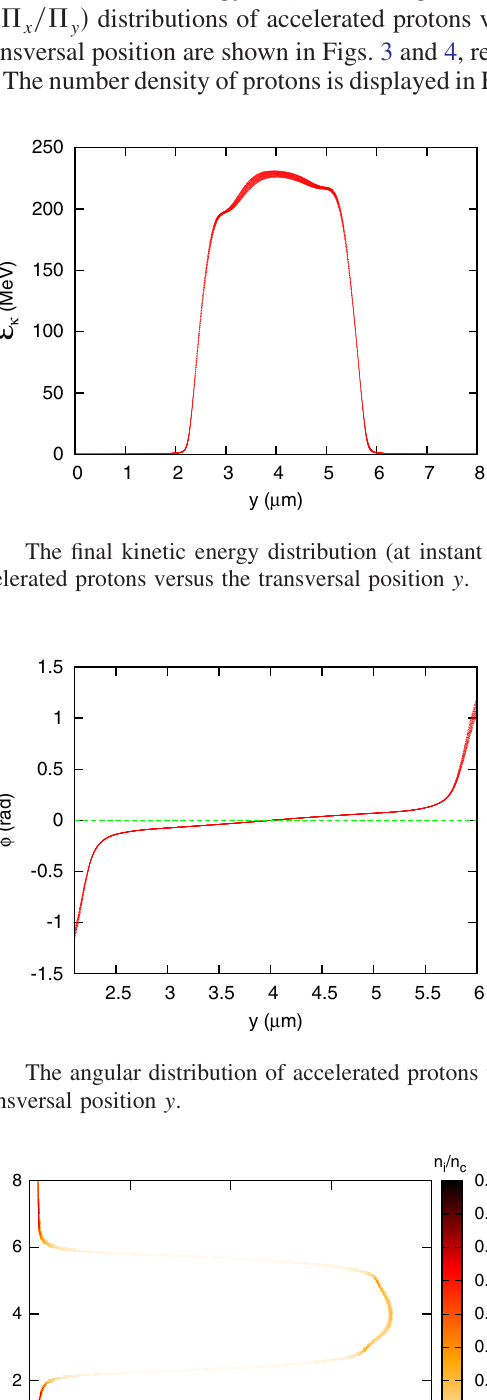
FIG. 2. Ion layer blown out from a thin foil by counterpropa- gating waves. The ( x - y ) phase space for protons at instants (1) , (2) 18 T , and (3) 21 T . 15 T 2 2 2